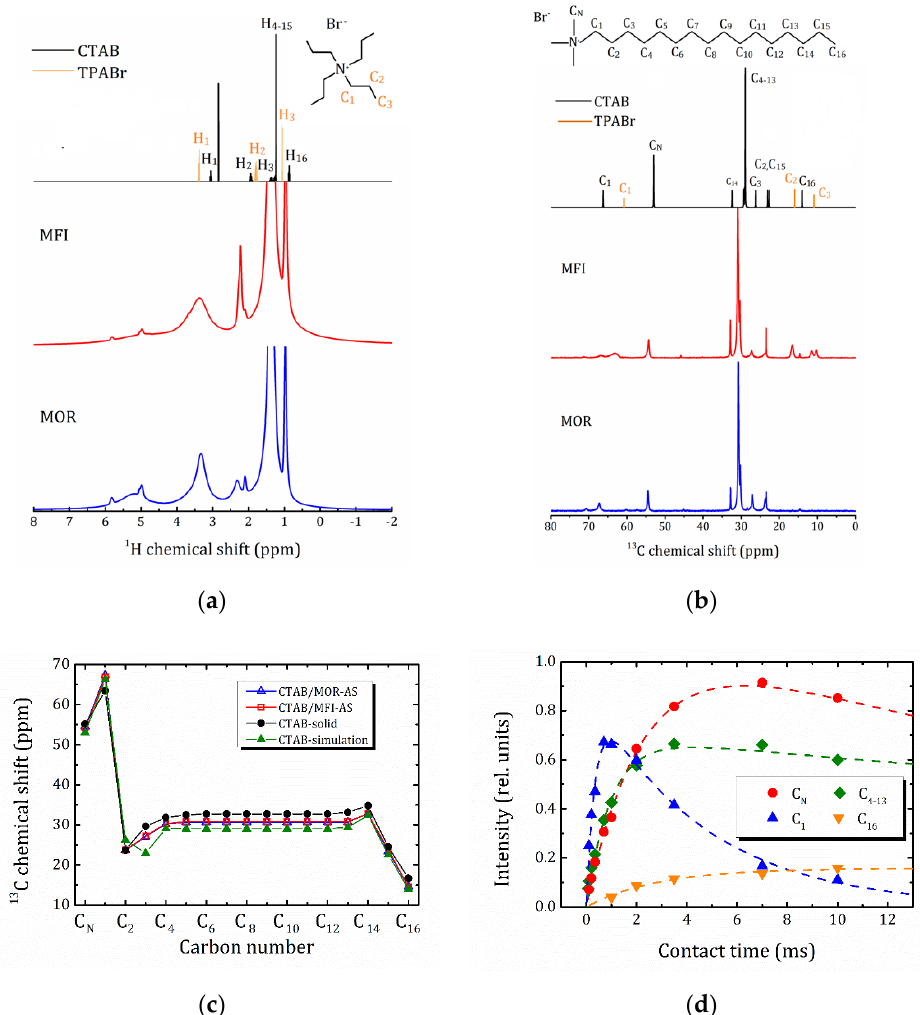
Figure 6. 1 H MAS NMR ( a ) and 13 C CP/MAS NMR at τ cp = 2 ms ( b ) spectra of the studied samples MOR-AS and MFI-AS with simulated spectra of CTAB and TPABr (at the top) given for a comparison; ( c ) 13 C isotropic chemical shift profiles of CTAB: CTAB/MOR-AS (open triangles), CTAB/MFI-AS (open squares), crystalline powder from Ref. [23] (closed circles), simulated using www.nmrdb.org [30] (closed triangles); ( d ) integral peak intensity for C N , C 1 , C 4–13 and C 16 atoms of CTAB in MOR-AS versus contact pulse duration τ cp (VCT experiment), dashed lines corresponds to the fitting within Equation (1).